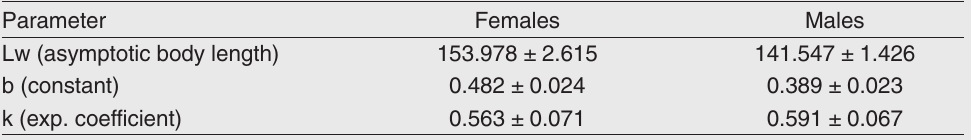
Table 1. Growth parameters (± S.E.) fitted to length (cm) at age (years) data in West Greenlandic harbour porpoises, using a modified (Lockyer et al. 2001) Gompertz model [Lt = Lw exp(- b exp(- k t))]. Sample sizes are 81 for males and 71 for females.